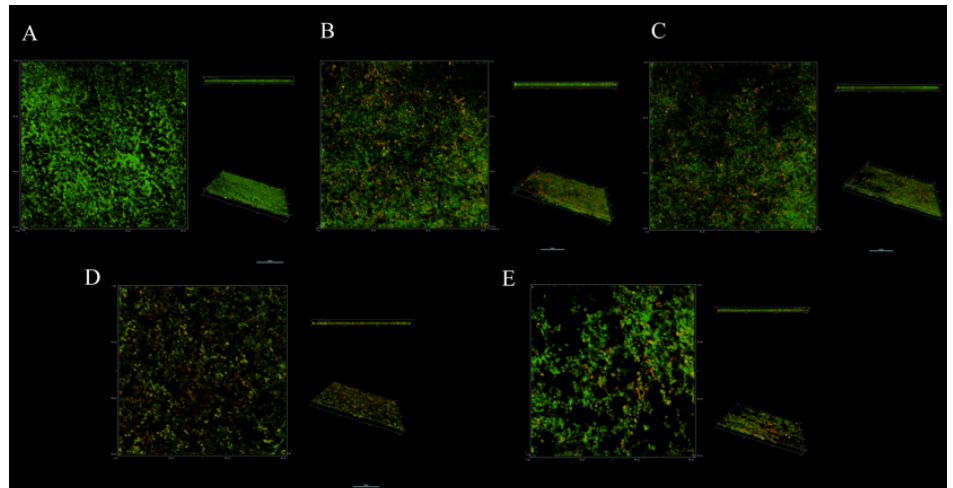
Figure 4. Effects of different treatments on H. pylori biofilm by CLSM. ( A ) (Control group): BB2, ( B ) (FIC group): 1× FIC of AMX and CLR, ( C ) (CF5 group): 6.25% CFS of 10 5 CFU/mL L. salivarus LN12 in combination with 1 × FIC of AMX and CLR, ( D ) (CF7 group): 6.25% CFS of 10 7 CFU/mL L. salivarus LN12 in combination with 1 × FIC of AMX and CLR, ( E ) (CF9 group): 6.25% CFS of 10 9 CFU/mL L. salivarus LN12 in combination with 1 × FIC of AMX and CLR. The scale bar is 10 μ m. Every group contains three views: the main view (observed horizontally along the x-y axis), the side view (ob- served horizontally along the x-z axis), and the view at a certain angle. AMX: Amoxicillin, CLR: Clarithromycin.